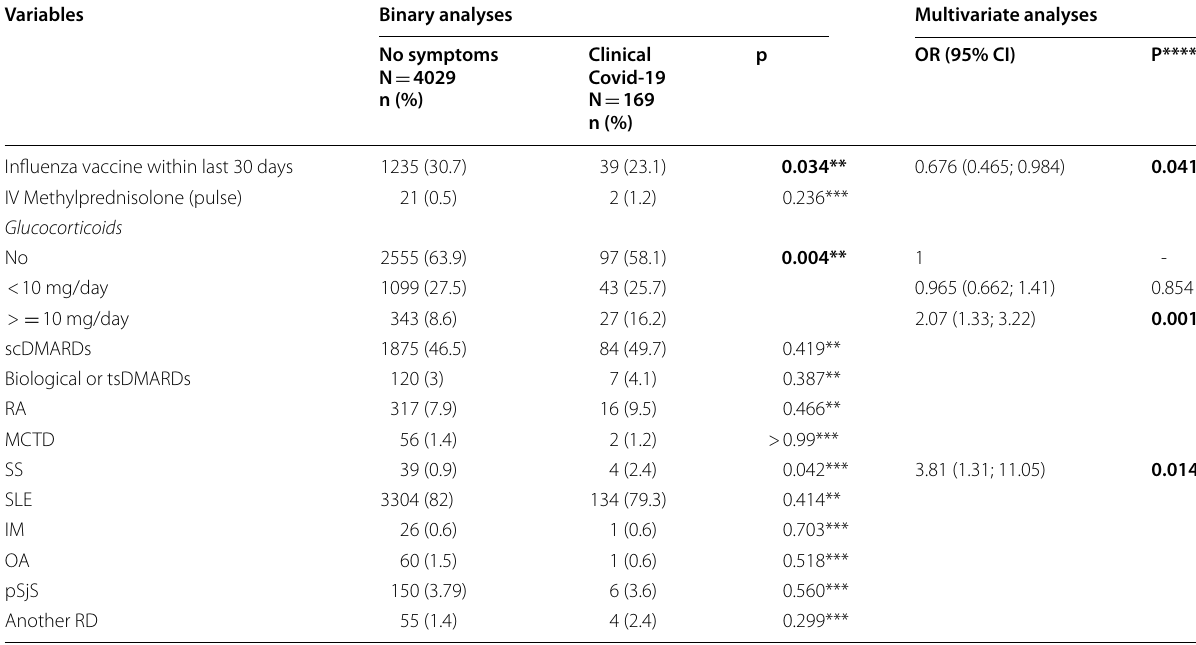
Bold values indicate statistical significance (p < 0.05) RA, Rheumatoid arthritis; SLE, Systemic lupus erythematous; RD, Rheumatic diseases; MCTD, Mixed connective tissue disease; SS, Systemic sclerosis; IM, Inflammatory myopathies; OA, Osteoarthritis; pSjS, Primary Sjögren syndrome; sc, synthetic conventional; ts, target-specific; DMARDs, Disease Activity-Modifying Drugs; Model 3, Outcome is COVID-19 diagnosis, according to the Brazilian Ministry of Health criteria; y, years; SD, standard deviation; med., median; min., minimum; max., maximum * Mann–Whitney test; **Chi-square test; ***Fischer’s exact test; ****Wald test by final logistic regression